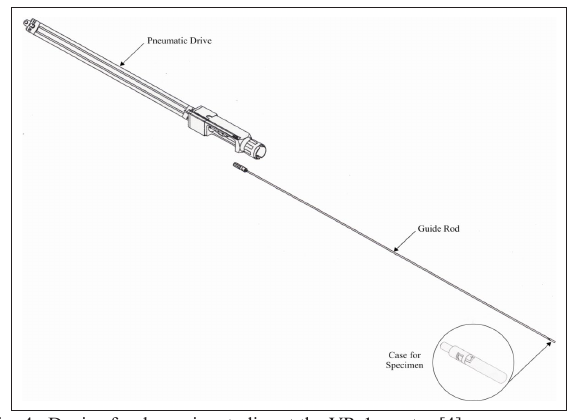
Fig. 4. Device for dynamics studies at the VR-1 reactor